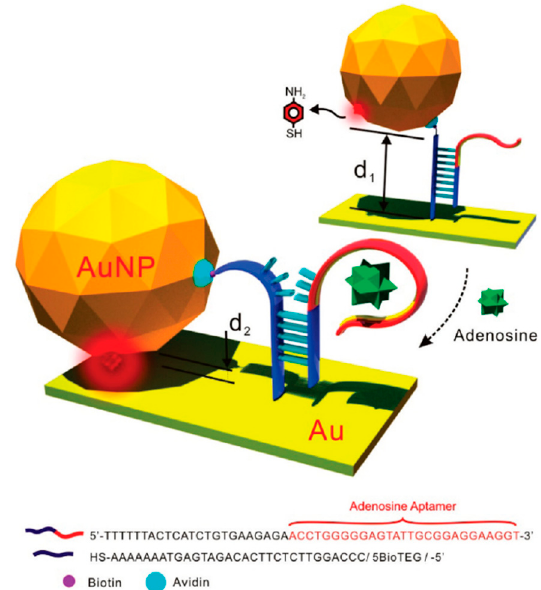
Figure 43. Example of aptamer-based SERS detection of adenosine. Reproduced with permission from Kim et al. [441]. Copyright (2010), American Chemical Society.